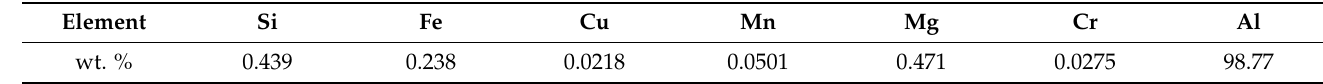
Table 1. Chemical composition of aluminum alloy A6063.